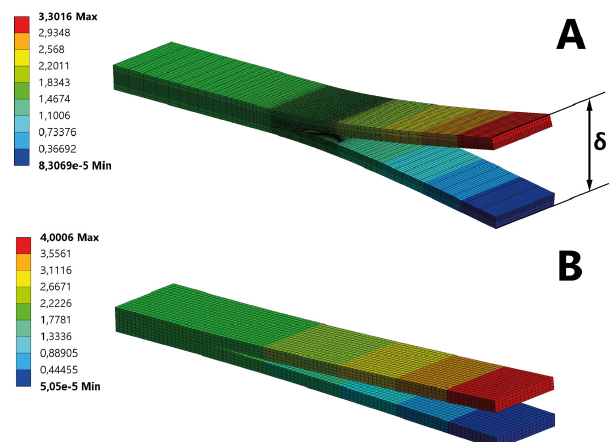
Figure 7. Final deformation of the UD230 models. Displacement δ applied to the model is represented with an arrow. Units in mm. A – mesostructured frictionless model. B – homogenized model.